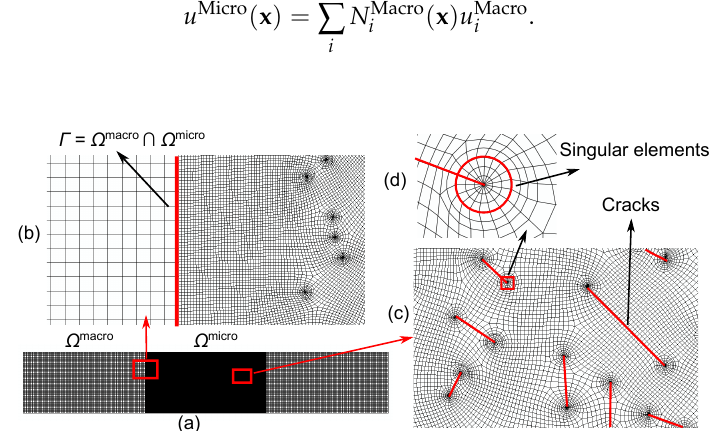
Figure 7. Multi-scale model of concrete beams. ( a ) Concrete model; ( b ) interface of macro-scale area and micro-scale area; ( c ) microcracks at micro-scale area; ( d ) singular